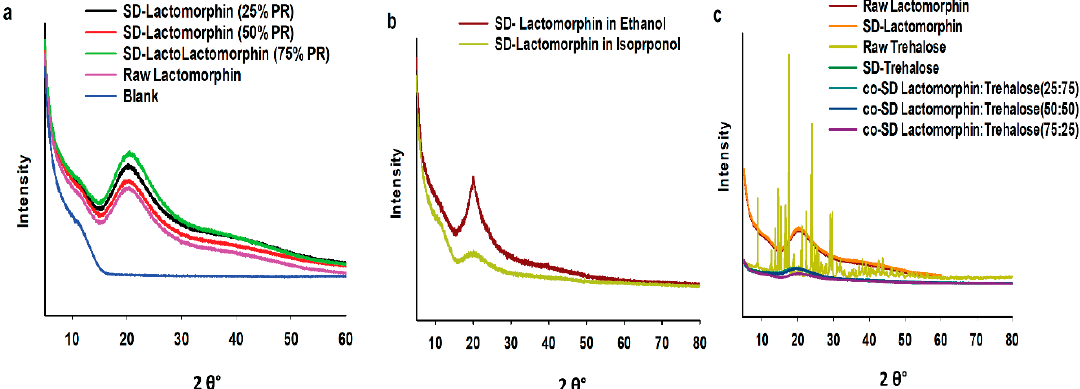
Figure 3. XRPD diffraction patterns for: ( a ). raw Lactomorphin, SD-Lactomorphin at all pump rates in methanol powders; ( b ). SD-Lactomorphin from two different feed solvents designed at low spray drying pump rate (25%); ( c ). raw Lacto- morphin, SD-Lactomorphin, raw Trehalose, SD-Trehalose, and Co-SD-Lactomorphin:Trehalose at different molar ratios designed at low spray drying pump rate (25%).